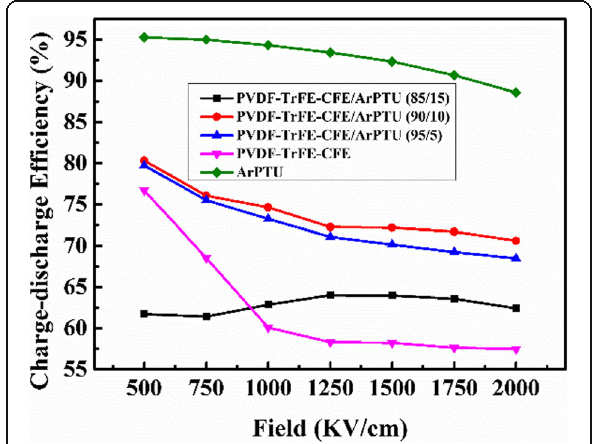
Fig. 9 Charge-discharge efficiency of PVDF-TrFE-CFE/ArPTU composite films with different composite